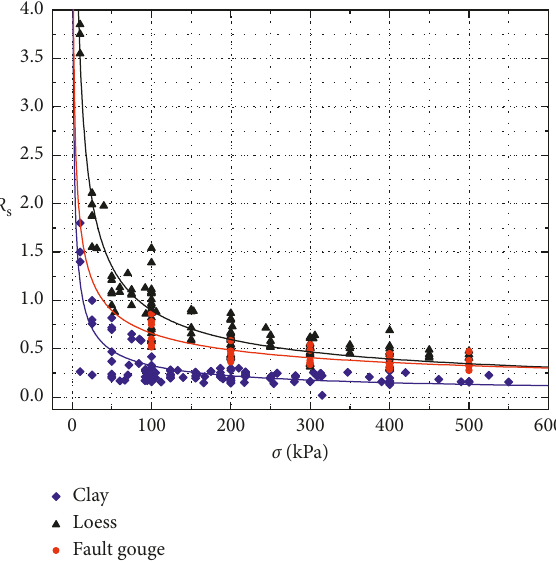
Figure 16: Fitting curves of R s with normal stress for different